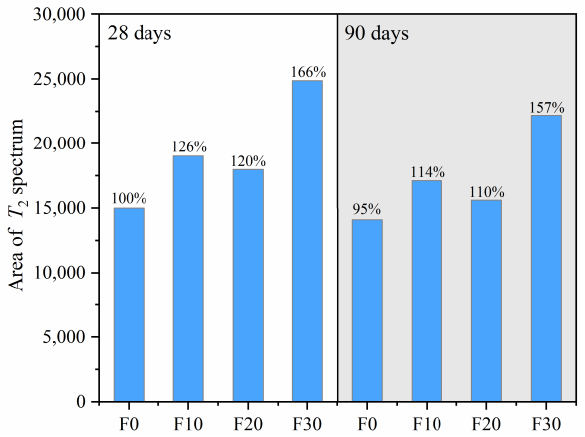
Figure 12. Integral area of the T 2 spectrum.